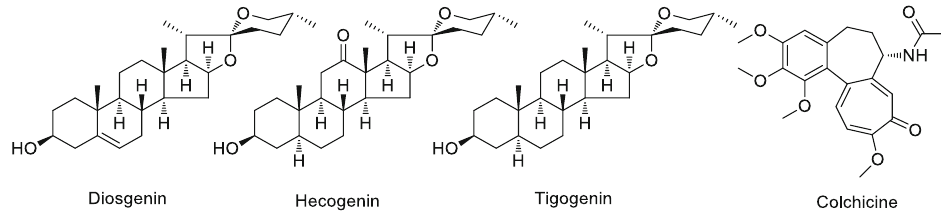
Fig. 3 Chemical structure of diosgenin, hecogenin, tigogenin and